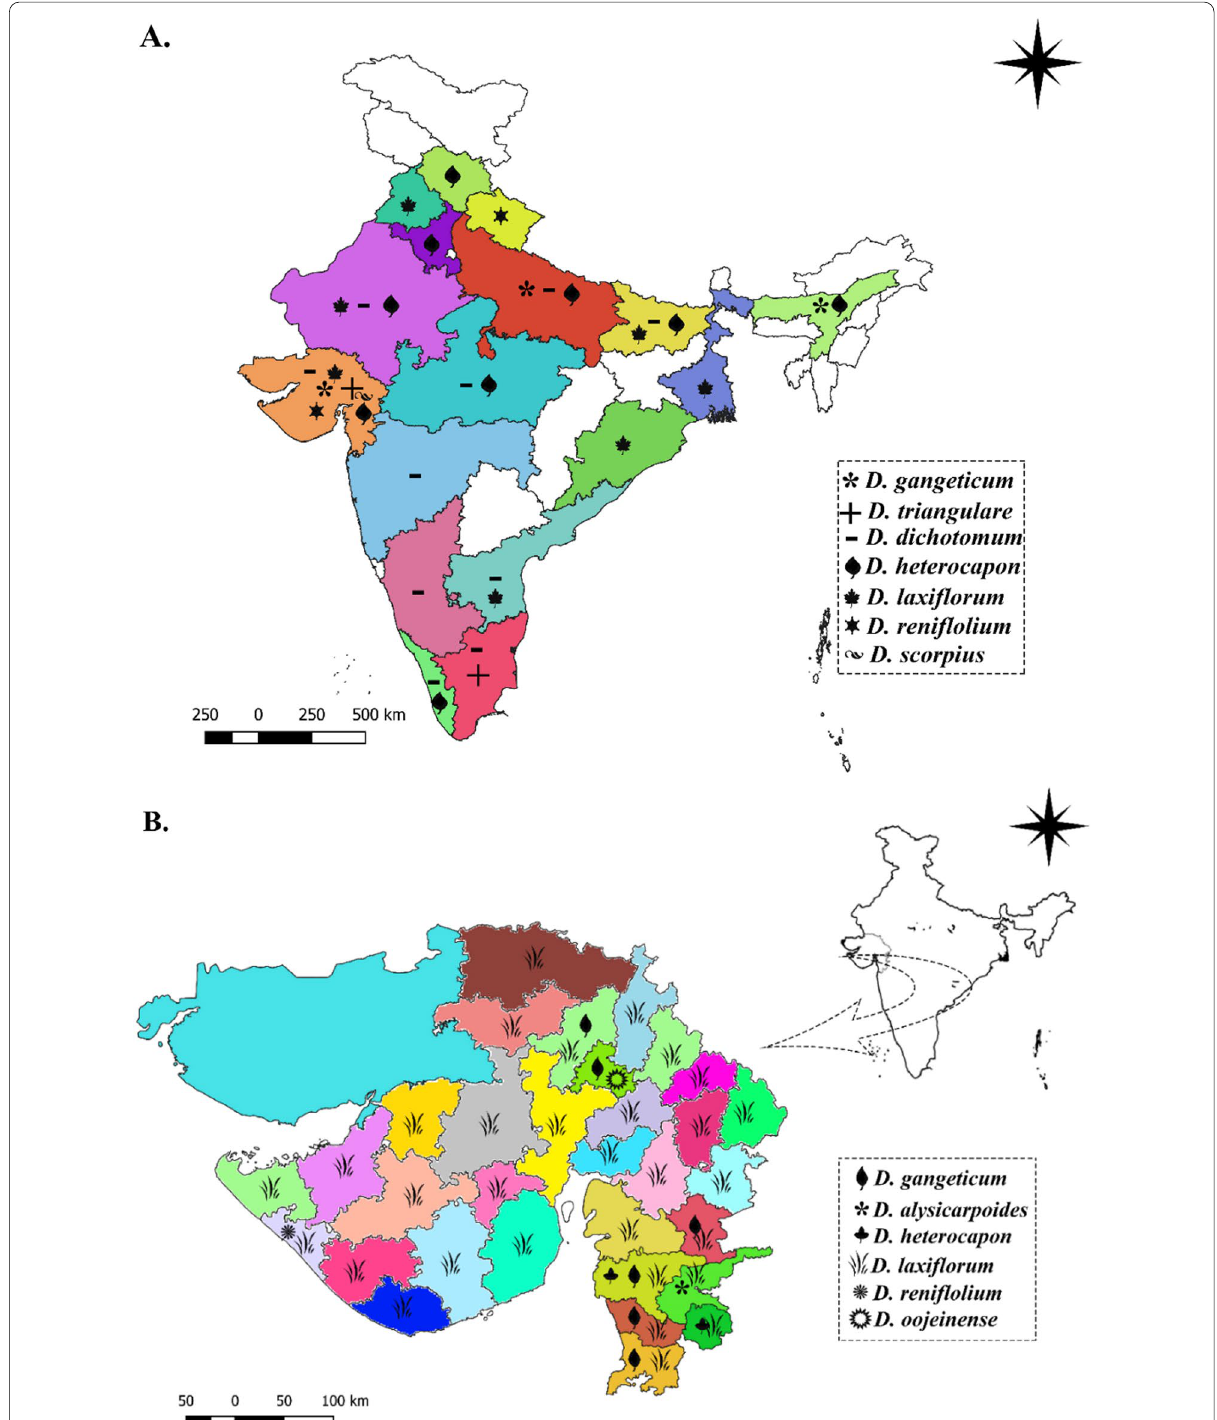
Fig. 2 A. Map showing the distribution of various Desmodium species throughout India B. Map showing the distribution of various Desmodium species throughout